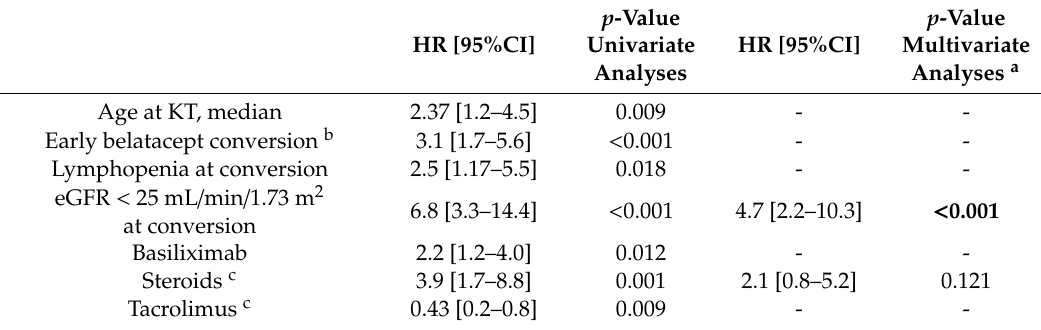
Table 3. Univariate and multivariate Cox’s analyses of the association between parameters at belatacept conversion and opportunistic